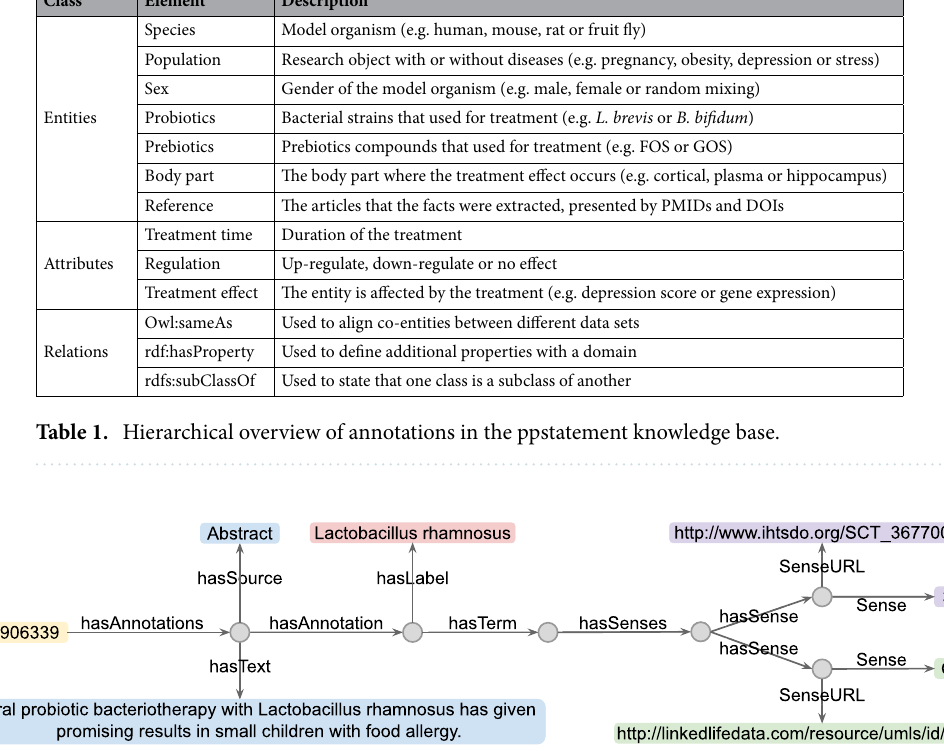
Figure 2. Illustration of the structure of ppconcept knowledge base. The yellow rectangle indicates the PMID. Gray dots are customized strings. Blue rectangles are free texts and the red one is the label of the annotated concept. Purple and green rectangles represent URLs from the SNOMED CT and UMLS databases,